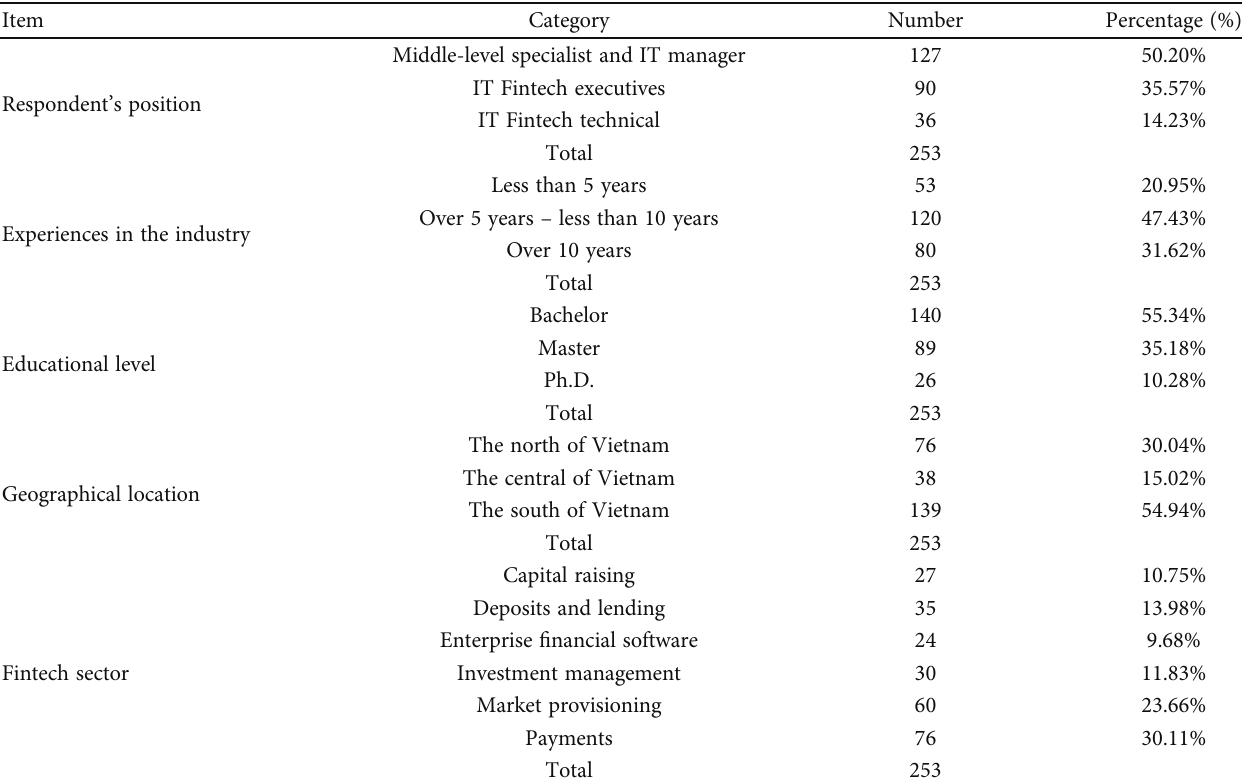
Table 1: Respondent pro fi le.